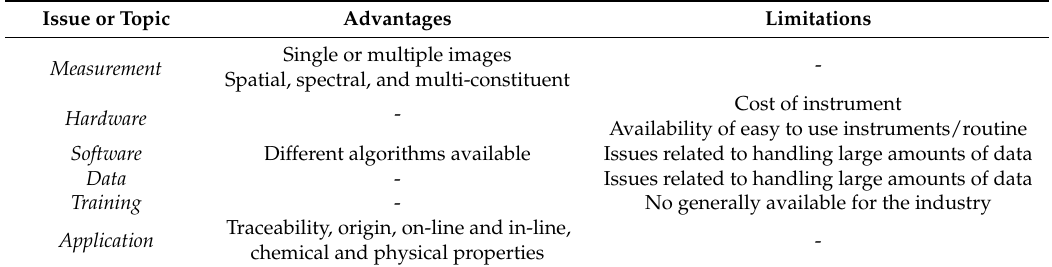
Table 1. Summary of the advantages and limitations of hyperspectral and multispectral imagine systems for the analysis of